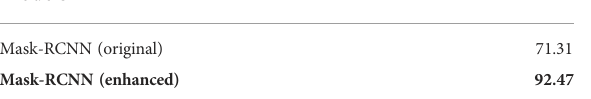
TABLE 1 Data enhancement test results.